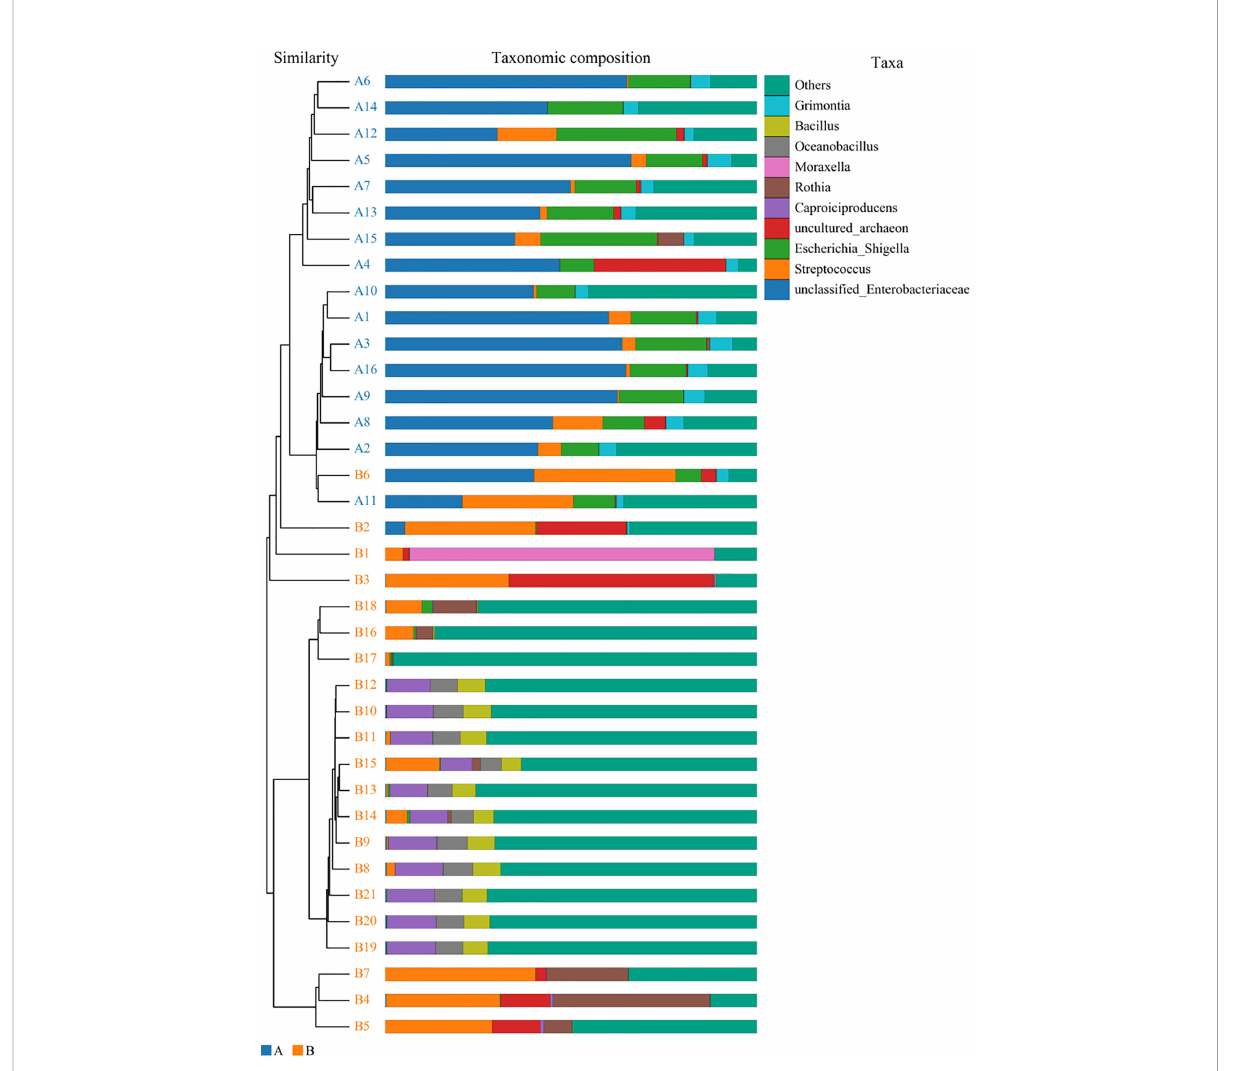
FIGURE 8 Unweighted pair-group method with arithmetic mean analysis. A1 – 16 mean the BALF samples of LRTI children with hematological malignancies, while B1 – 21 stand for the samples of LRTI children without hematological